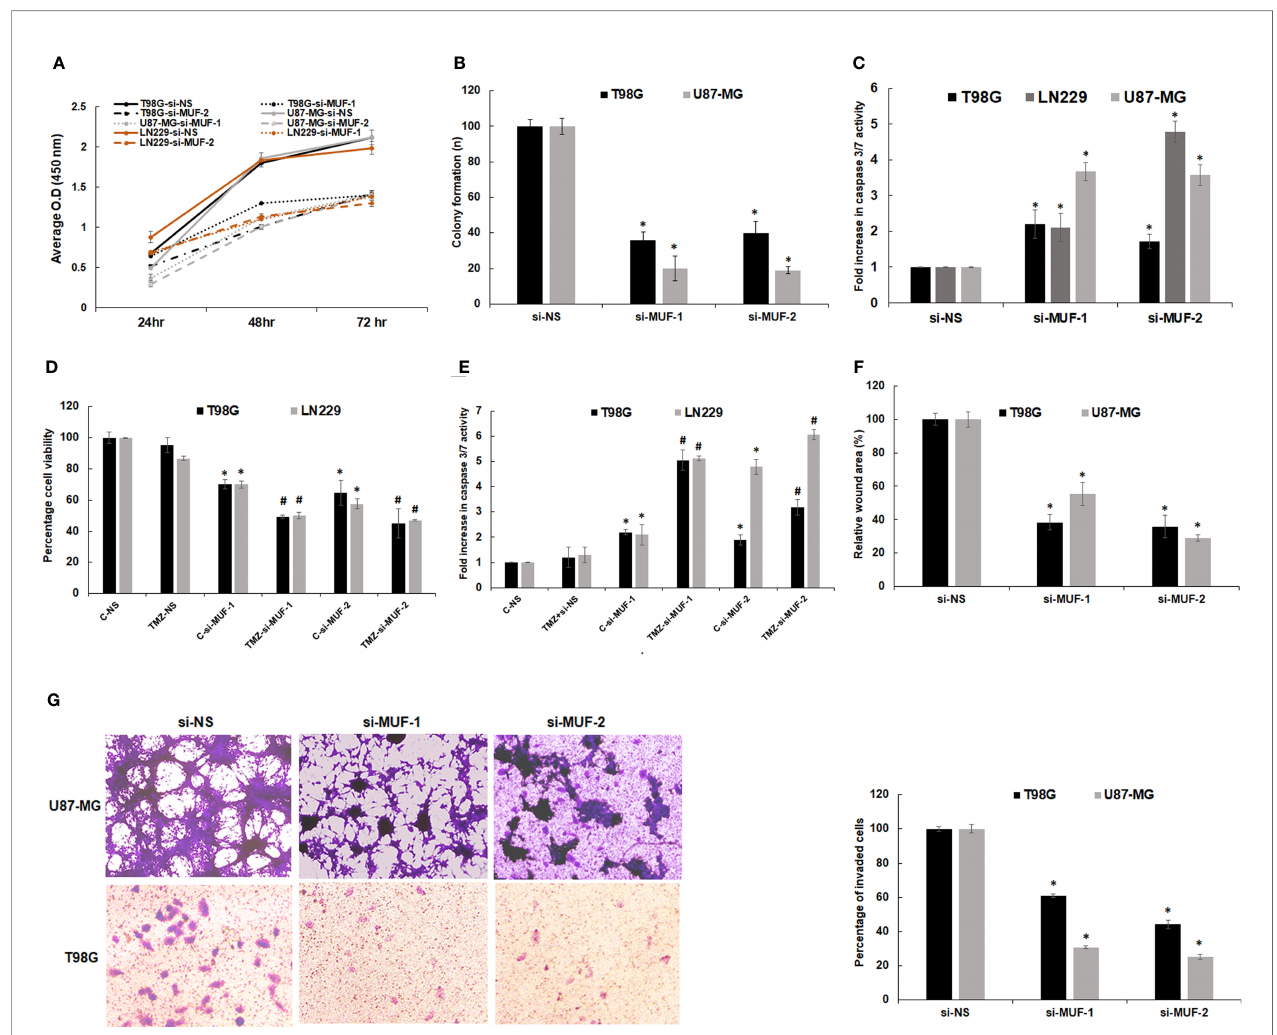
FIGURE 3 | Effect of lncRNA-MUF knockdown on glioma cell proliferation, migration, and invasion in vitro . (A) Human glioma cells were transfected with si-NS or si- MUF-1/si-MUF-2 (40 nM), and percentage cell viability was calculated at indicated times using WST1. Values represent mean ± S.D. from four independent experiments. *Signi fi cant change compared to si-NS cells at the corresponding time (p < 0.05). Statistical comparisons were made using Student ’ s t-test. (B) Reduced colony formation ability of GBM cells with lncRNA-MUF knockdown. (C) Caspase 3/7 activity assay shows that lncRNA-MUF knockdown induces apoptosis in GBM cells. (D) LncRNA-MUF knockdown with a low dose of si-MUF1/si-MUF-2 (20 nM) in combination with TMZ treatment (600 µM) shows enhanced reduction of glioma cell (T98G and LN229) proliferation and increased sensitivity to TMZ, as analyzed using WST1 assay. (E) LncRNA-MUF knockdown (20 nM of si-MUF-1/si-MUF-2) combined with TMZ treatment (600 µM) show enhanced caspase 3/7 activity as compared to TMZ alone. (F) Wound healing assay demonstrates reduced GBM cell migration upon lncRNA-MUF knockdown. (G) Matrigel invasion assay shows that lncRNA MUF inhibition reduces glioma cell invasion. Values represent mean ± S.D. from four independent experiments. *Signi fi cant change compared to si-NS cells at the corresponding time (p < 0.05). Statistical comparisons were made using Student ’ s t-test. # Signi fi cant decrease from C-si-MUF-1 and C-si-MUF-2 trabsfected cells (p <